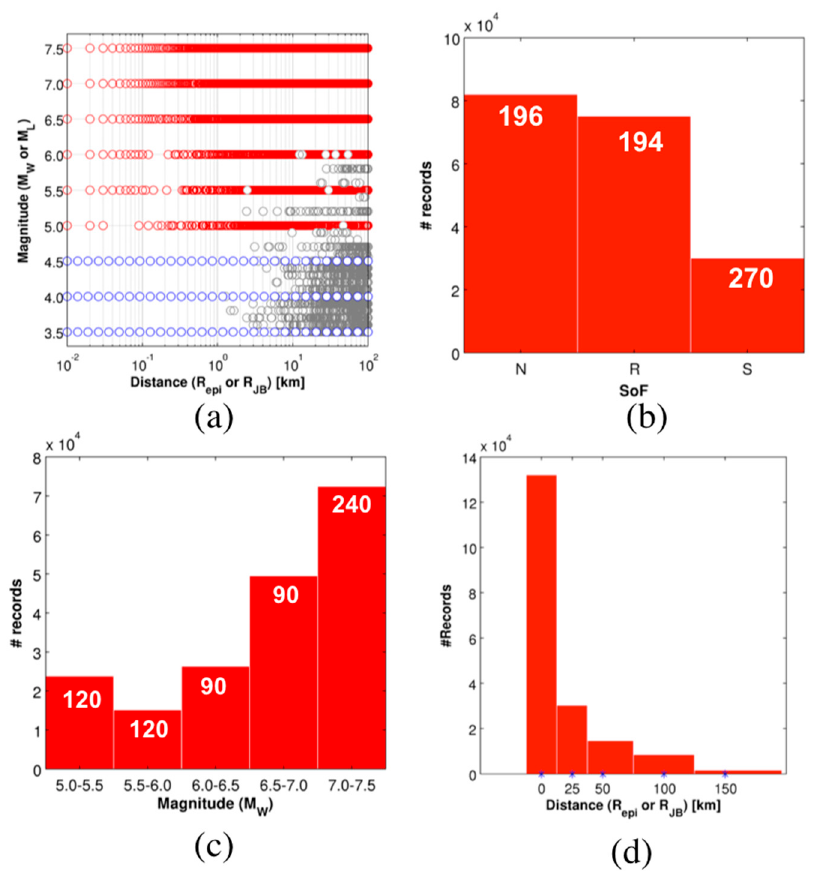
Figure 12. ( a ) Magnitude (M W , M L ) versus distance distribution of empirical (gray circles) and synthetic (GSs, red circles; PLs, blue circles) flat-file; ( b , d ) Distribution of the simulated waveforms as a function of style of faulting (N, normal faults; R, reverse faults; S, strike-slip faults) ( b ); Magnitude bins ( c ); and fault-to-site distance (R JB , Joyner and Boore; R epi , epicentral) ( d ). The number of the scenario events is also reported.